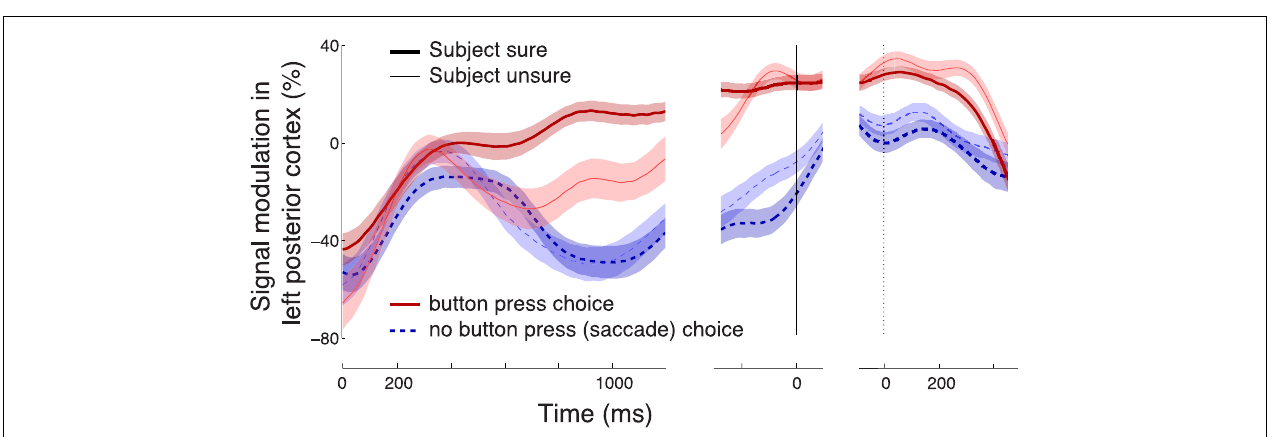
FIGURE 6 | Effects following a trial elimination procedure. Elimination of trials in which EEG signals at any channel exceeded a particular threshold (Section 2) had only minimal impact on the confidence-related effect. Same format as in Figure 5B .